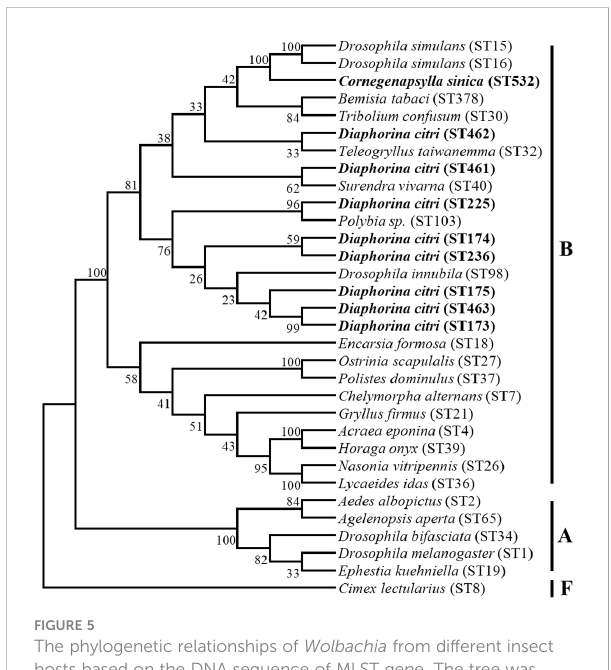
FIGURE 5 The phylogenetic relationships of Wolbachia from different insect hosts based on the DNA sequence of MLST gene. The tree was constructed and analyzed by Neighbor-Joining (NJ) method using 1000 bootstraps